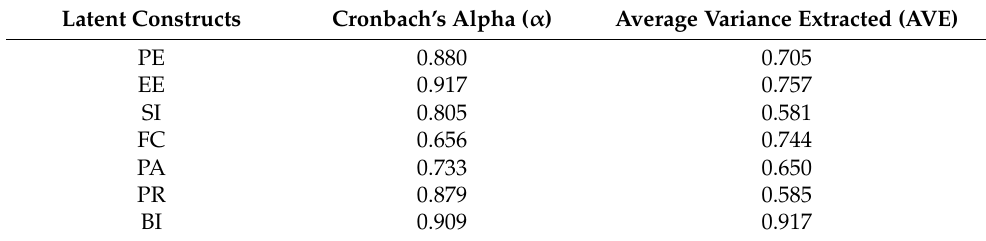
Table 3. Reliability and factor